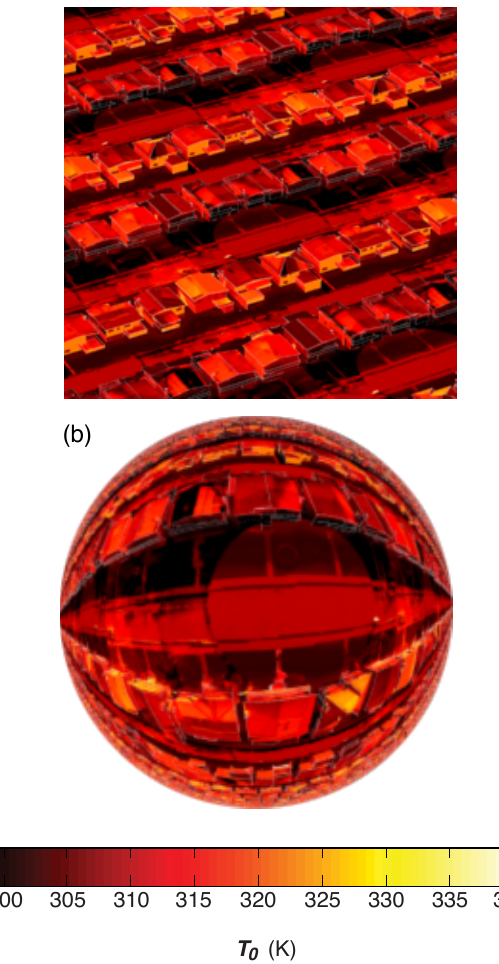
Figure 4. Examples of rendered (a) narrow FOV and (b) hemispher- ical radiometer rendering at